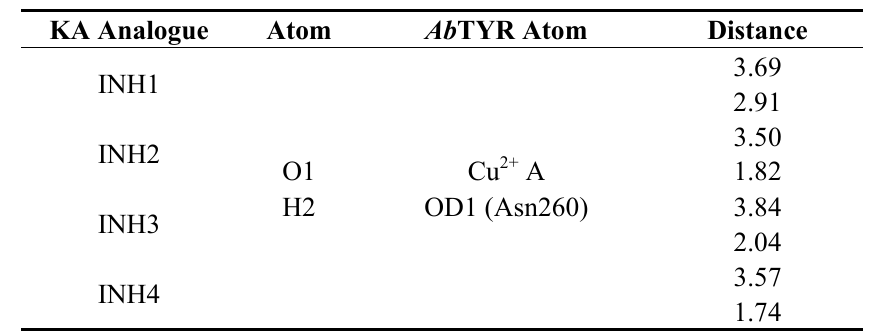
Table 2. Atomic distances obtained by molecular docking procedure. The atoms O1 and H2 were numbered using 2D structure of KA as show in Table 1. All distances are calculated in Å.